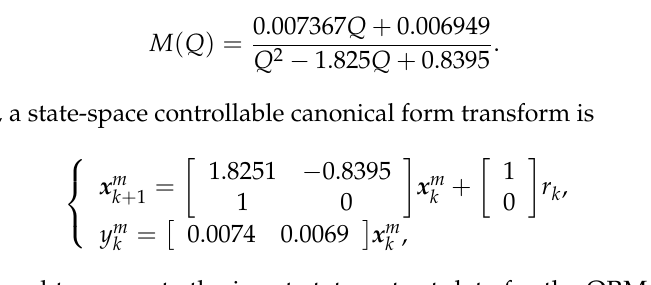
Figure 1. Hardware connection between the engine, motor driver and Arduino Board [31].